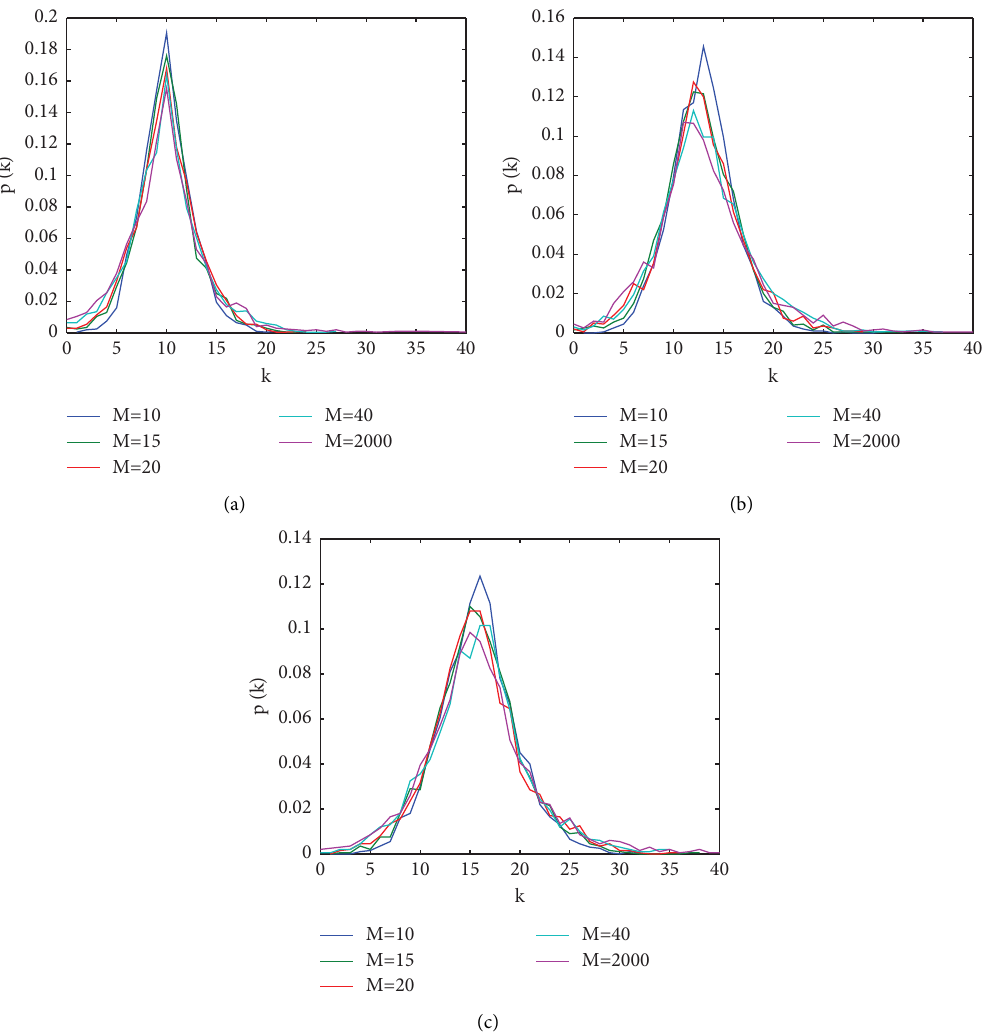
Figure 3: Stationary degree distribution of networks for diferent values of M . Results are obtained by stochastic simulations according to the network generating algorithm in Section 3.1, where the initial network has a Poisson degree distribution with mean m ( p + 1 ) . Te parameters are m � 10, T � 20000, (a) p � 0, (b) p � 0 . 3, and (c) p � 0 .